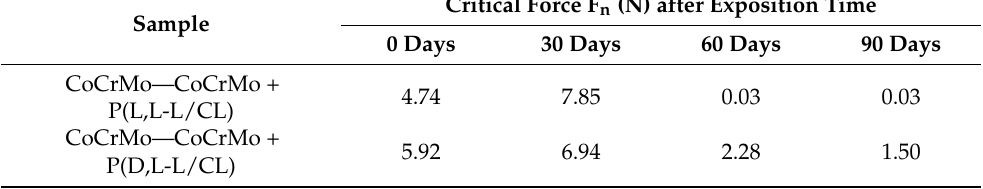
Table 2. Summary of test results for the adhesion of P(L,L-L/CL) and P (D,L-L/CL) coatings to the substrate.